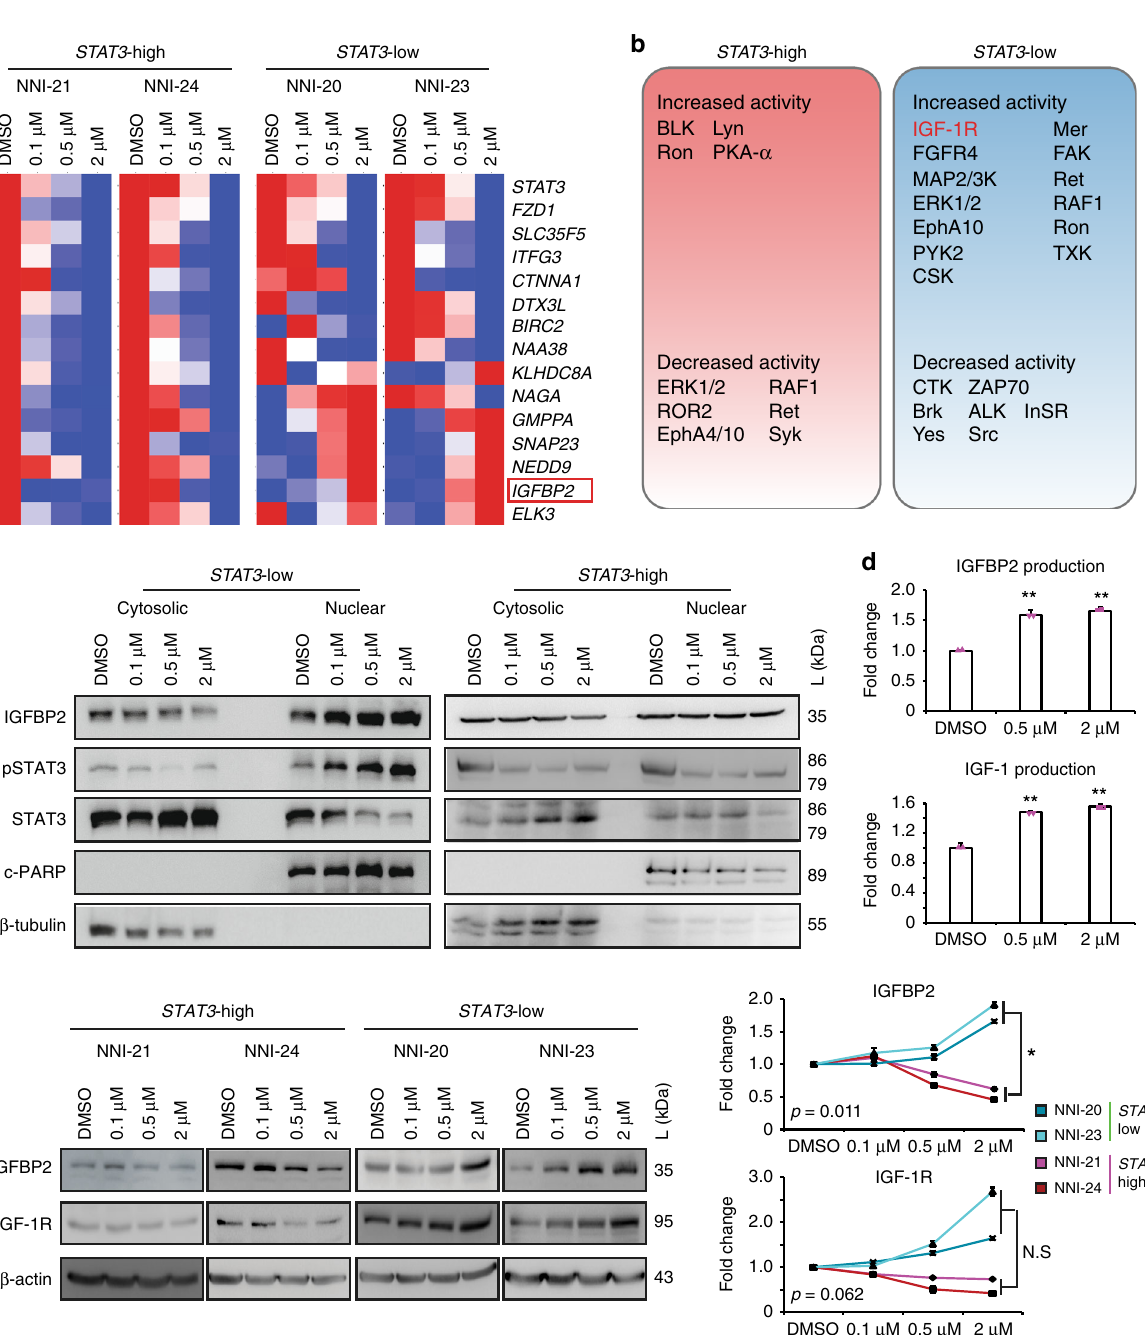
NATURE COMMUNICATIONS| (2019) 10:3601